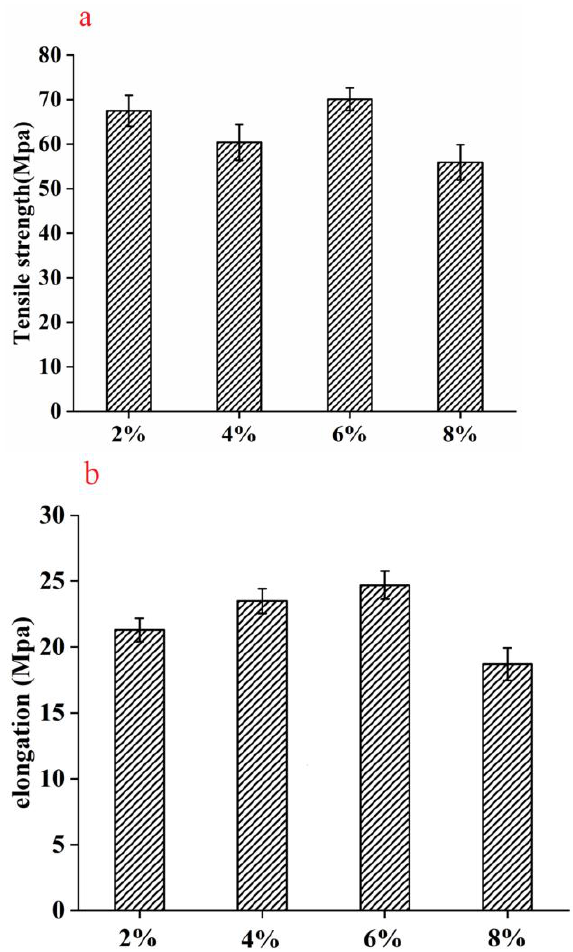
( a ) tensile strength and ( b ) Figure 8. Mechanical properties of nylon6/pig nail keratin nanofiber membranes, including ( a ) ten- sile strength and ( b ) elongation.